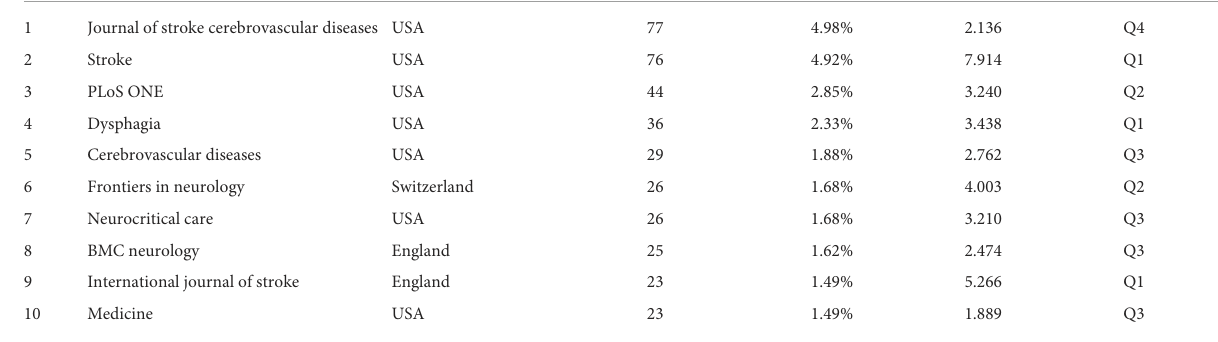
TABLE 4 The top 10 most productive journals between 1998 and